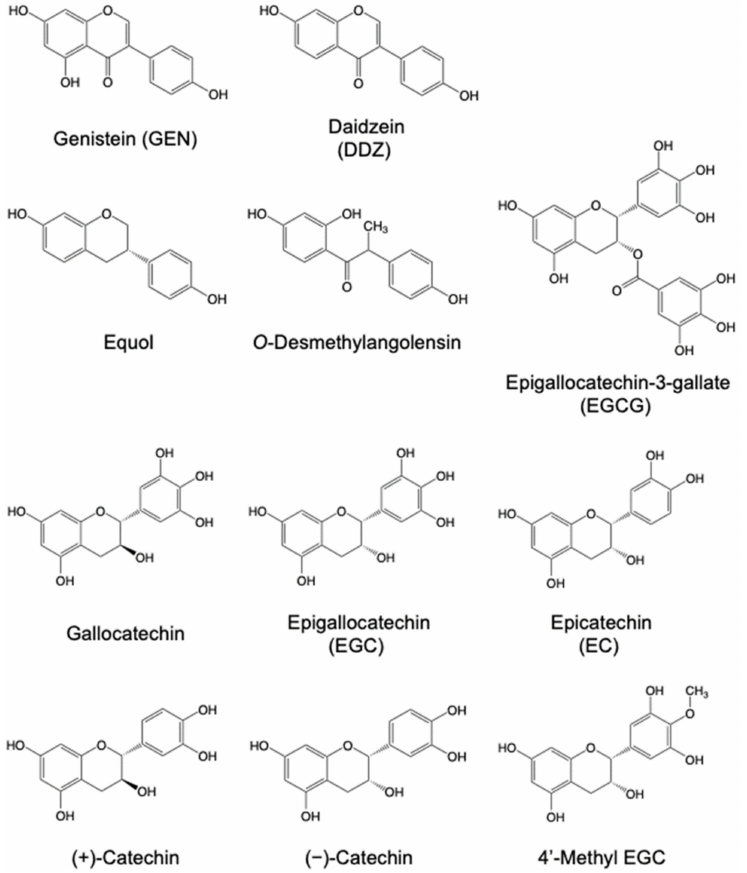
Figure 1. Chemical structures of representative flavonoids and their urinary